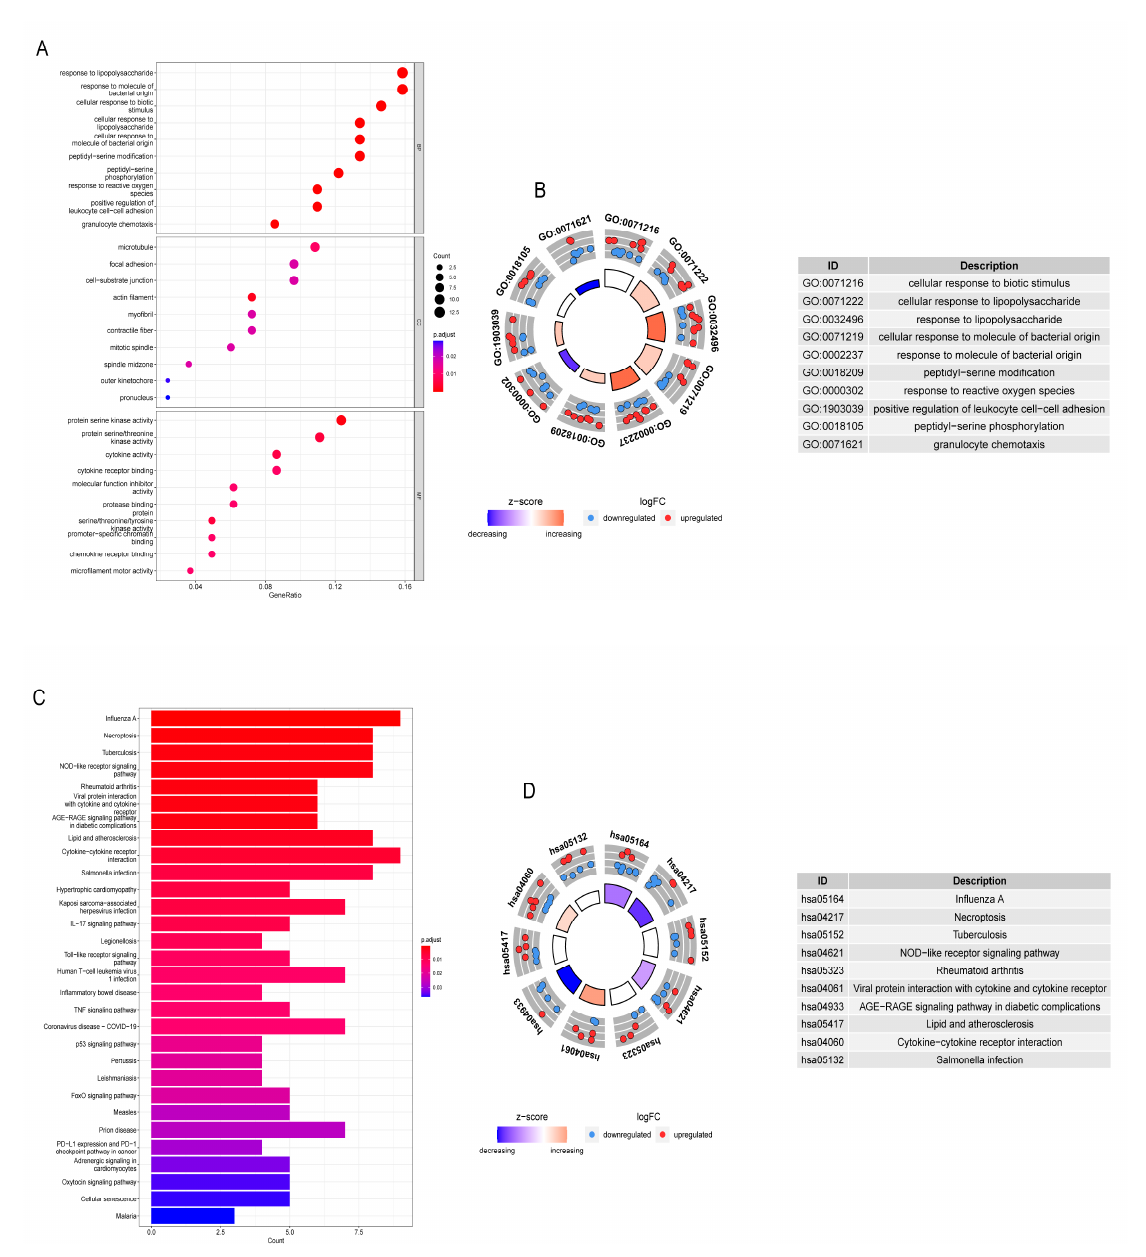
Figure 4. GO and KEGG analysis of NRGs in GC. ( A , B ) GO analysis of diff-NRGs. ( C , D ) KEGG analysis of diff NRGs. (all p <